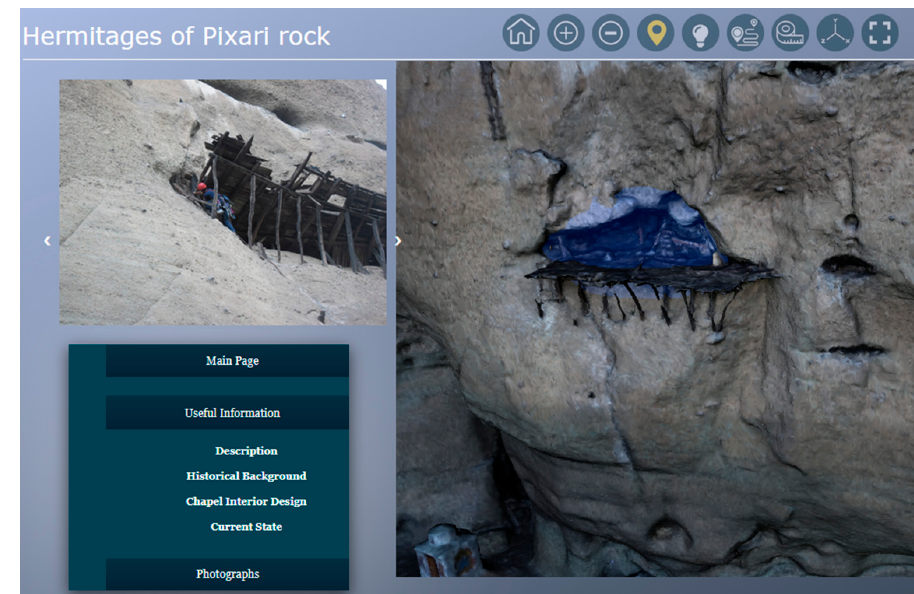
Figure 10. Real-time adjustment of menu contents and its corresponding information for the selected hotspot.